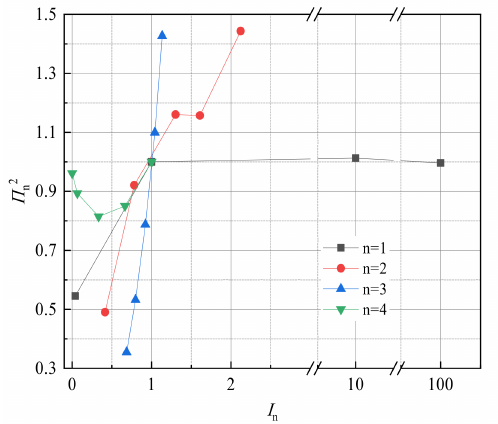
Figure 21. Sensitivity analysis of flue gas waste heat